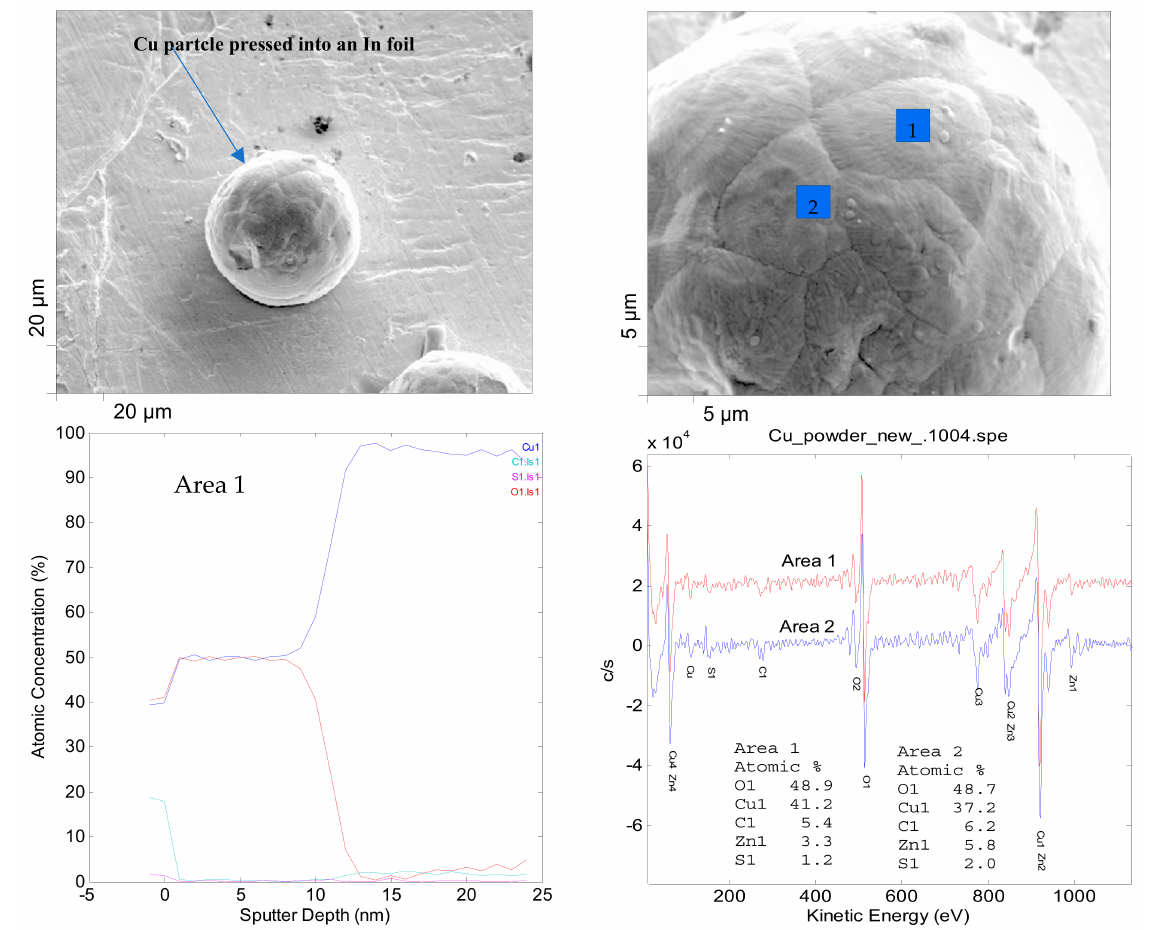
Figure 4. AES measurements of Cu particles with less than 149 µ